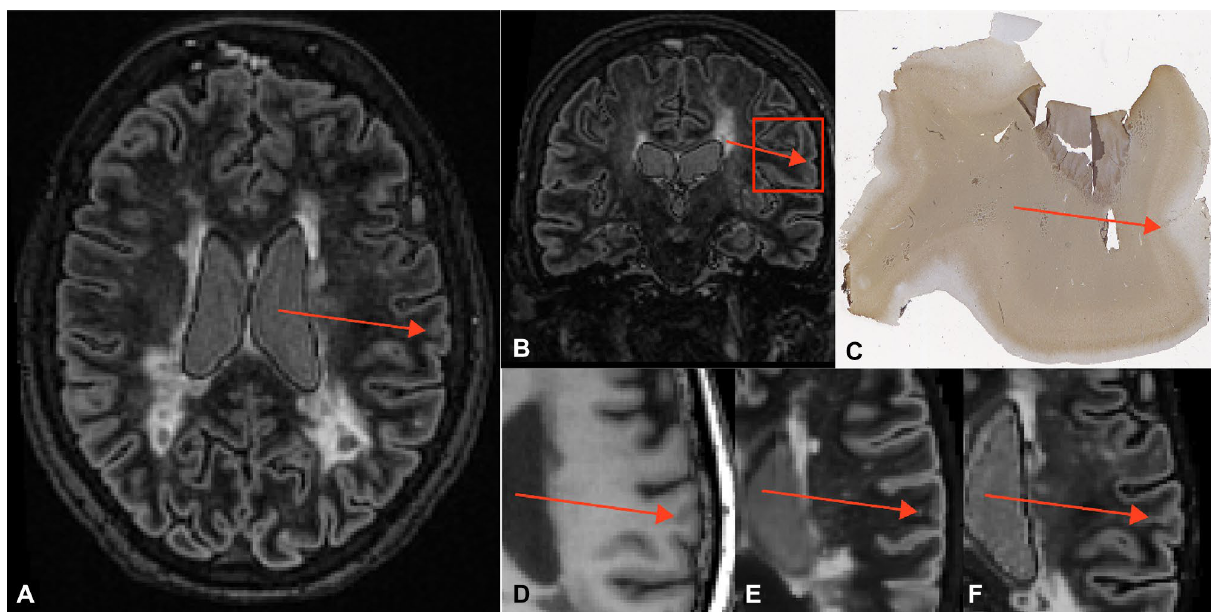
Figure 2. False-positive. Example of a ‘false-positive’, an area of partial demyelination or remyelination that has been scored as a cortical lesion on all (conventional and artificial) DIR sequences. The panels depict the conventionally acquired DIR image in axial fashion ( A ), a coronal image as a reference for the histopathological sample ( B ), the histopathological sample that has been stained for myelin ( C ), 3D-T 1 ( D ), artificial DIR generated from 3D-T 1 and PD/T 2 ( E ), and artificial DIR generated from 3D-T 1 and FLAIR ( F ). The partial demyelination/remyelination area is indicated by the red arrow on all panels (generated using